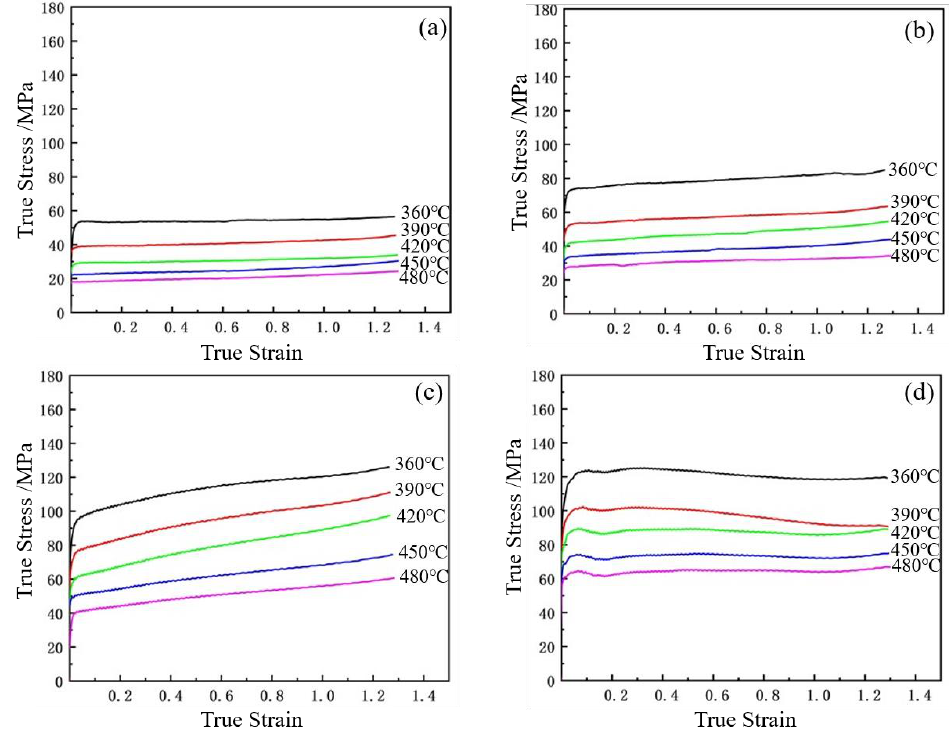
Figure 3. True stress–true strain curves for hot compression deformation of AC AA2195 Al-Li alloy at different temperatures and strain rates: ( a ) 0.01 s − 1 , ( b ) 0. 1 s − 1 , ( c ) 1 s − 1 , ( d ) 10 s − 1